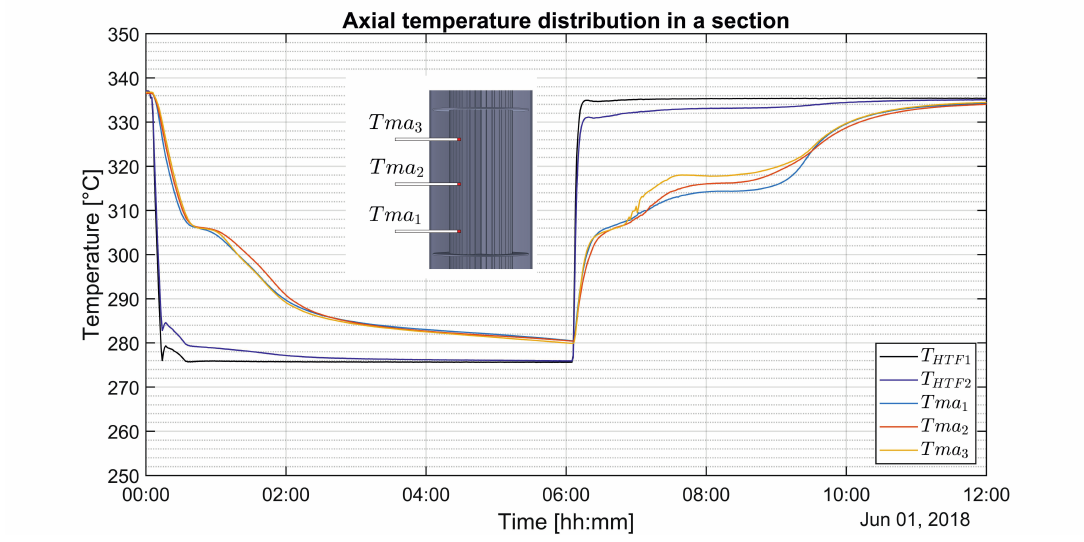
Figure 9. Axial temperature distribution in the PCM in a